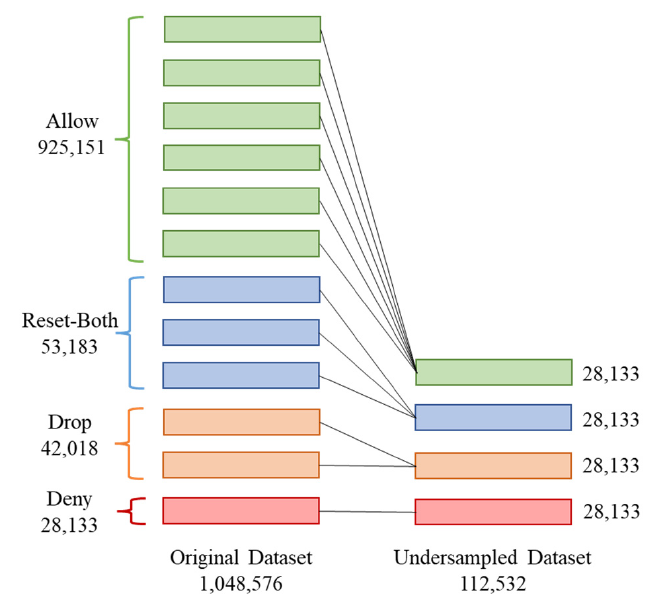
Figure 2. Dataset before and after randomized under-sampling was applied.